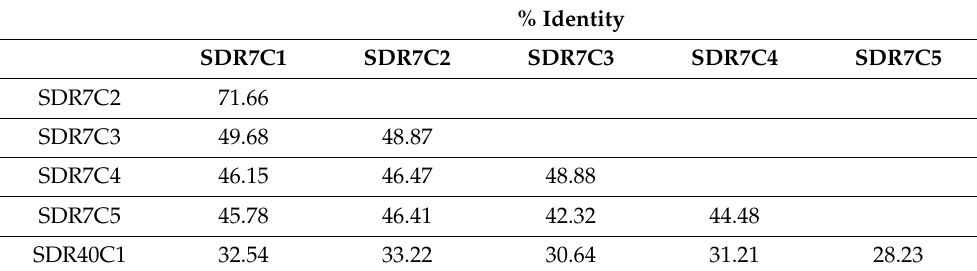
Table 2. The percent identity of the human SDR7C family and human SDR40C1 protein variants. %